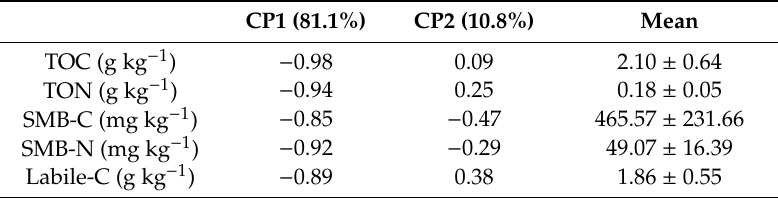
Figure 1. Principal component analysis (PCA) using the variables: Total organic carbon (TOC) and organic nitrogen (TON), soil labile-C (g kg − 1 ), soil microbial biomass carbon (SMB-C), and nitrogen (SMB-N) for surface (0.0–0.1 m) and subsurface (0.1–0.2 m) layers. In the figure, Group 1 (black) represents the subsurface for agriculture soil, Group 2 (white) represents surface / subsurface for forested soil, and Group 3 (red) represents surface for agriculture soil. Table 2. Factor coordinates for each variable, based on correlations with total organic carbon (TOC) and nitrogen (TON), labile-C, soil microbial biomass carbon (SMB-C), and